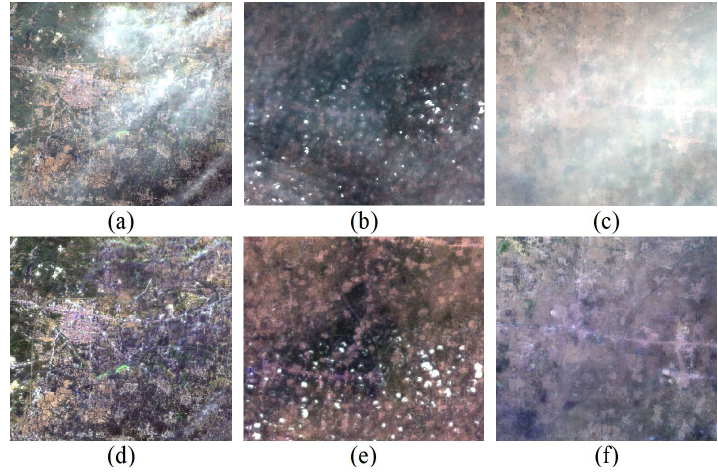
Figure 10. Dehazing results (sub-scenes) of MODEL-O. ( a – c ) hazy sub-scenes cut out from a full scene (path 123, row 033, acquisition date 23 September 2015); ( d – f ) dehazed images using